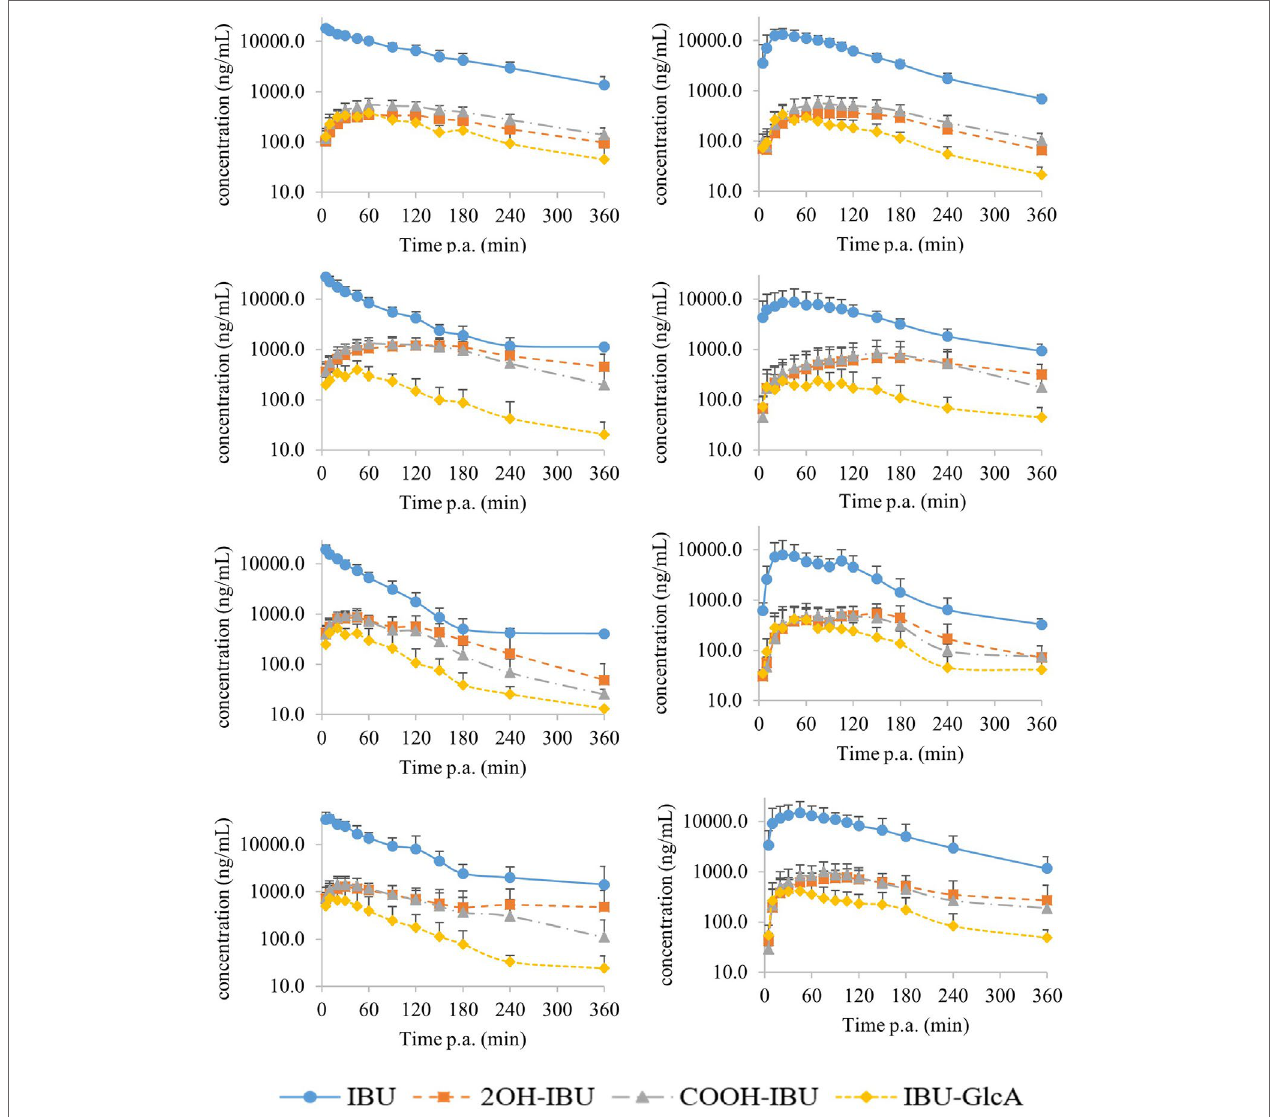
FIGURE 2 | The mean (±SD) log concentration–time profiles after intravenous (IV) (left) and oral (PO) (right) administration of 5 mg/kg BW of ibuprofen (blue dots) with their corresponding metabolites 2-hydroxyibuprofen (2OH-IBU, orange square), carboxyibuprofen (COOH-IBU, gray triangle), and ibuprofen glucuronide (IBU- GlcA, yellow diamond). From top to bottom are the curves for the 1-week-old, 4-week-old, 8-week-old, and 6- to 7-month-old pigs (each time, 8 pigs, 4 ♂ , 4 ♀ ) represented, respectively. Time post administration